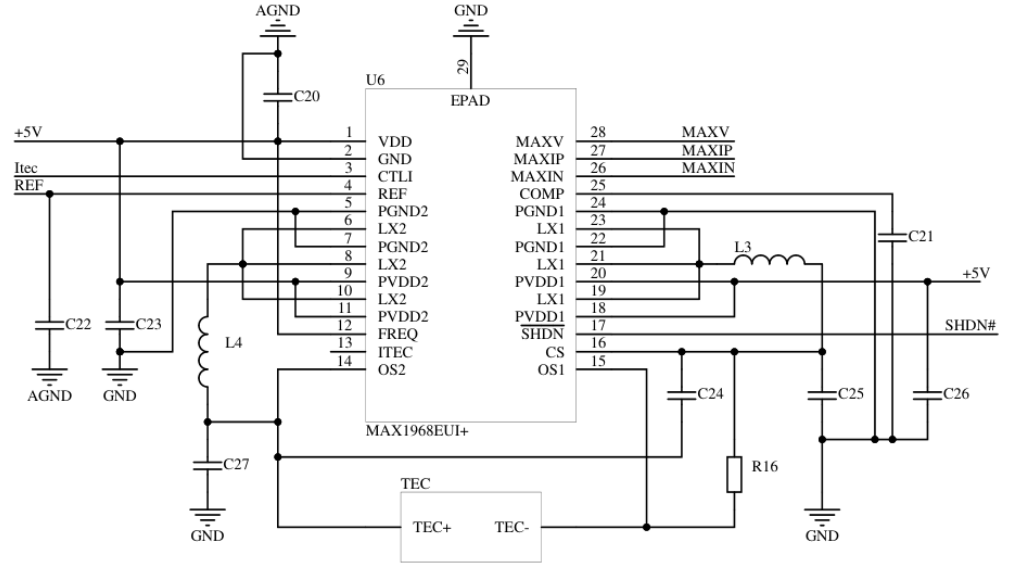
Figure 7. The TEC drive